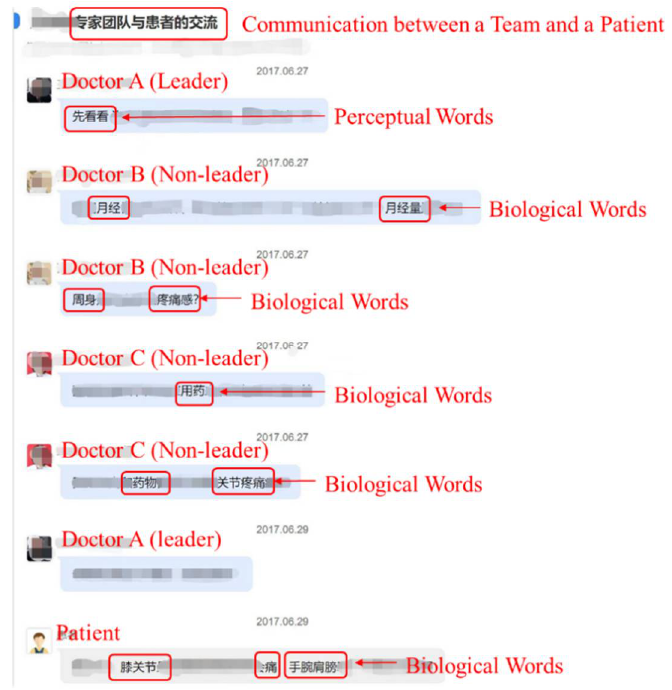
Figure 3. Doctor–patient communication page with patients (incomplete screenshot).